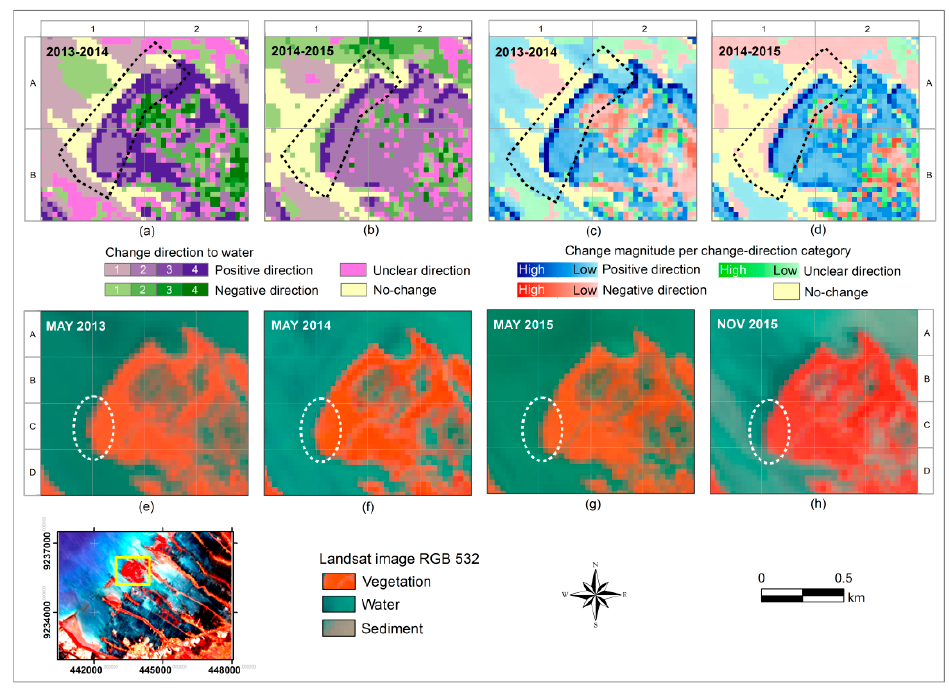
Figure 12. Multi-year pattern of water membership changes showing a high change direction to positive direction (see dark violet pixels in black-dashed polygons in ( a , b )) and high change magnitude (see dark blue pixels in black-dashed polygons in ( c , d )). RGB 542 of Landsat images show a decrease of vegetation coverage from 2013 to 2015 (see white-dashed ellipses in ( e – h )).